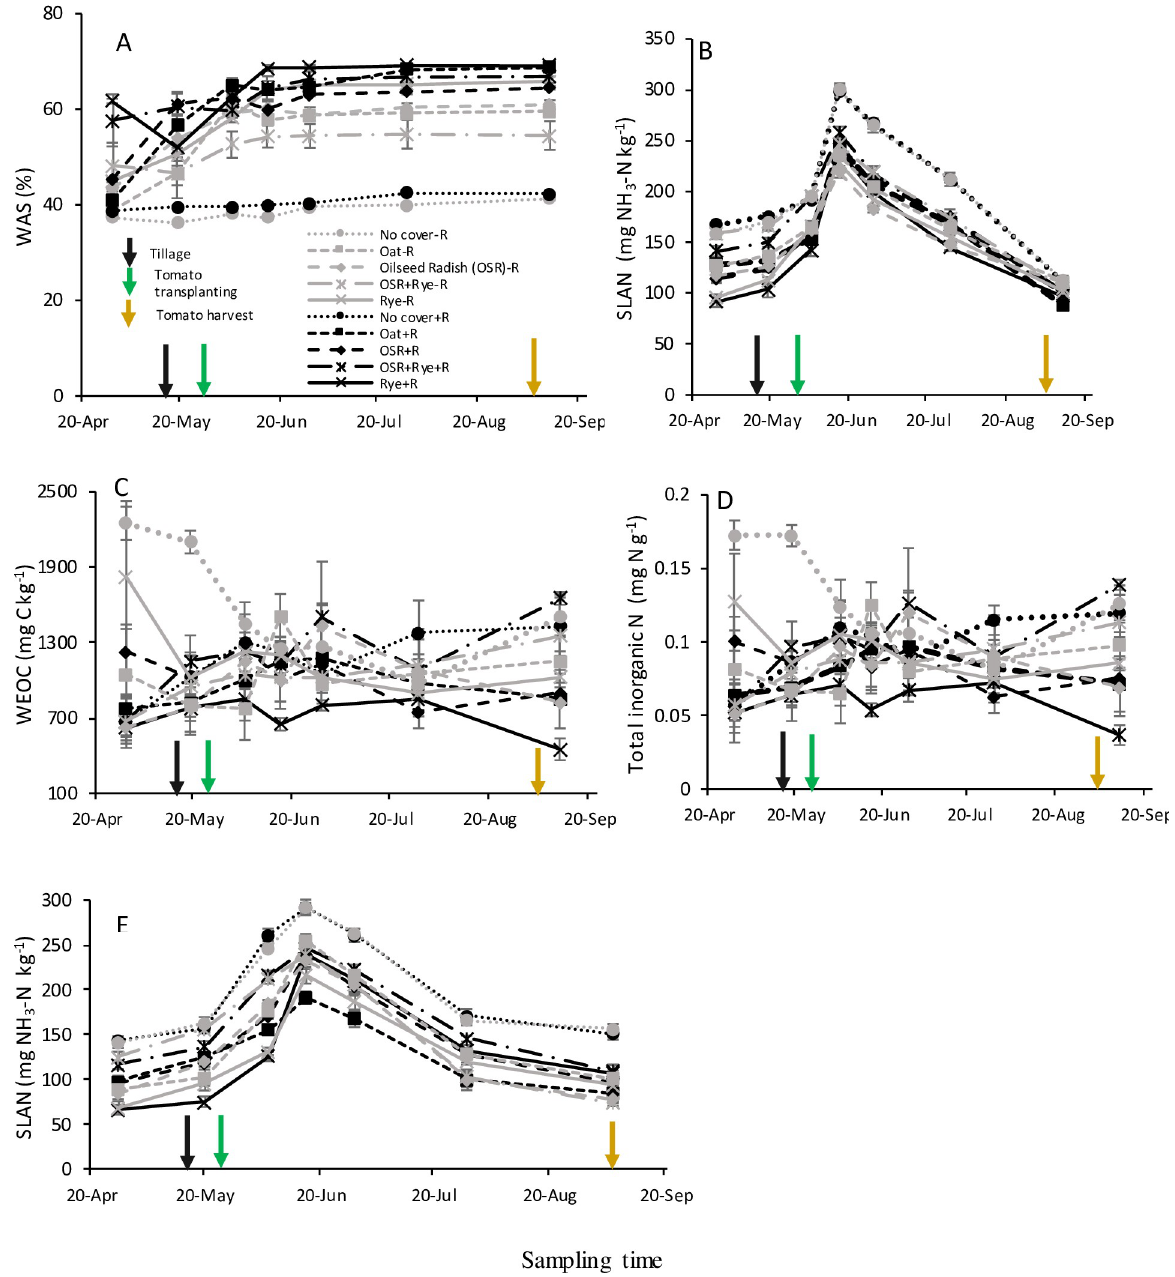
Fig 5. In site-year 2015 (A-D) and site-year 2016 (E), effect of medium-term summer-planted cover crop (6-yrs) and crop residue retained (+R) or removed (-R) on soil labile and stable fractions of C and N from 0–15 cm depth over the tomato growing season. Bars represent standard error of means (n = 4). SLAN, Solvita labile amino N; WAS, wet aggregate stability; WEOC, water extractable organic C; WEON, water extractable organic N.